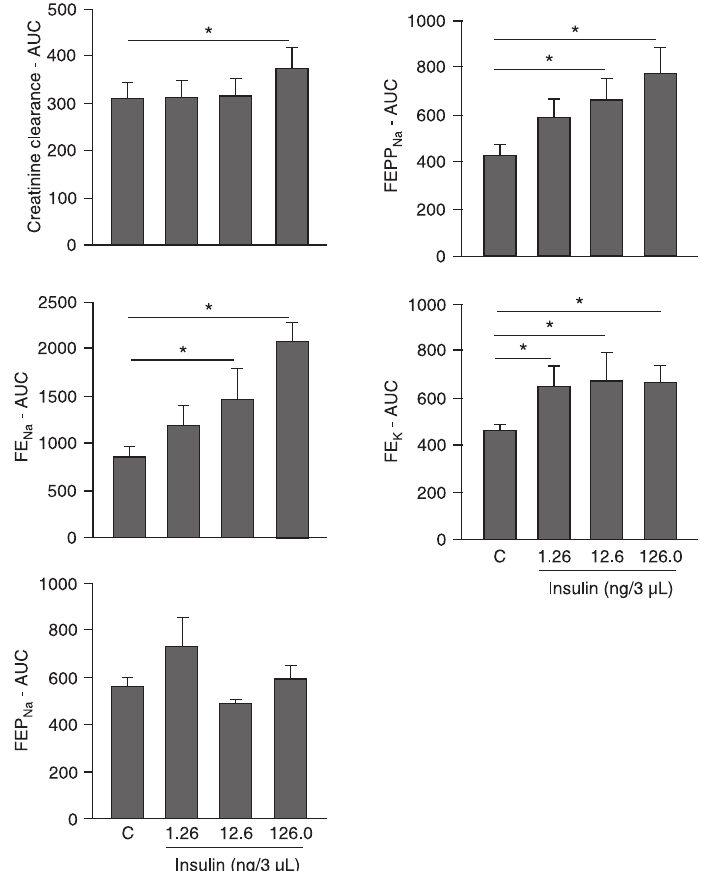
Figure 1. Effect of lateral intracerebroventricular microinjection of 0.15 M NaCl (C) or dose-related (1.26, 12.6 and 126.0 ng in a volume of 3 µL) insulin in Wistar-Hannover rats on creatinine clearance, fractional excretion of sodium (FE Na ), proximal (FEP Na ) and post- proximal (FEPP Na ) fractional excretion of sodium, and fractional excretion of potassium (FE K ). AUC = area under the curve. Data are reported as means ± SEM. *P ≤ 0.05 as indicated by the horizontal lines (ANOVA and Bonferroni’s contrast